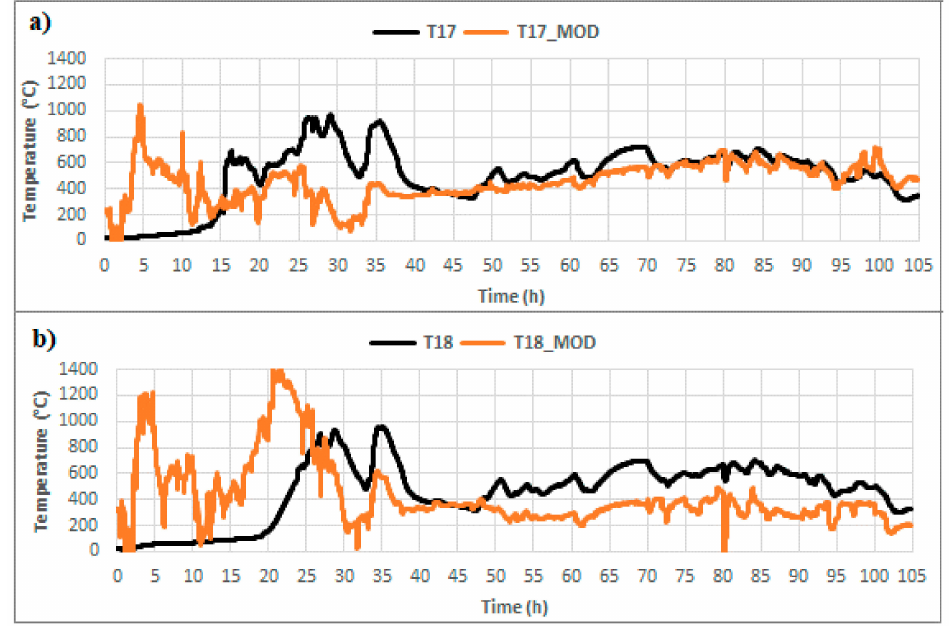
Figure 14. The measured (T) and modeled (T_MOD) temperature behavior in the first phase verifica- tion, ( a ) temperature T 17 , ( b ) temperature T 18 (Source: own